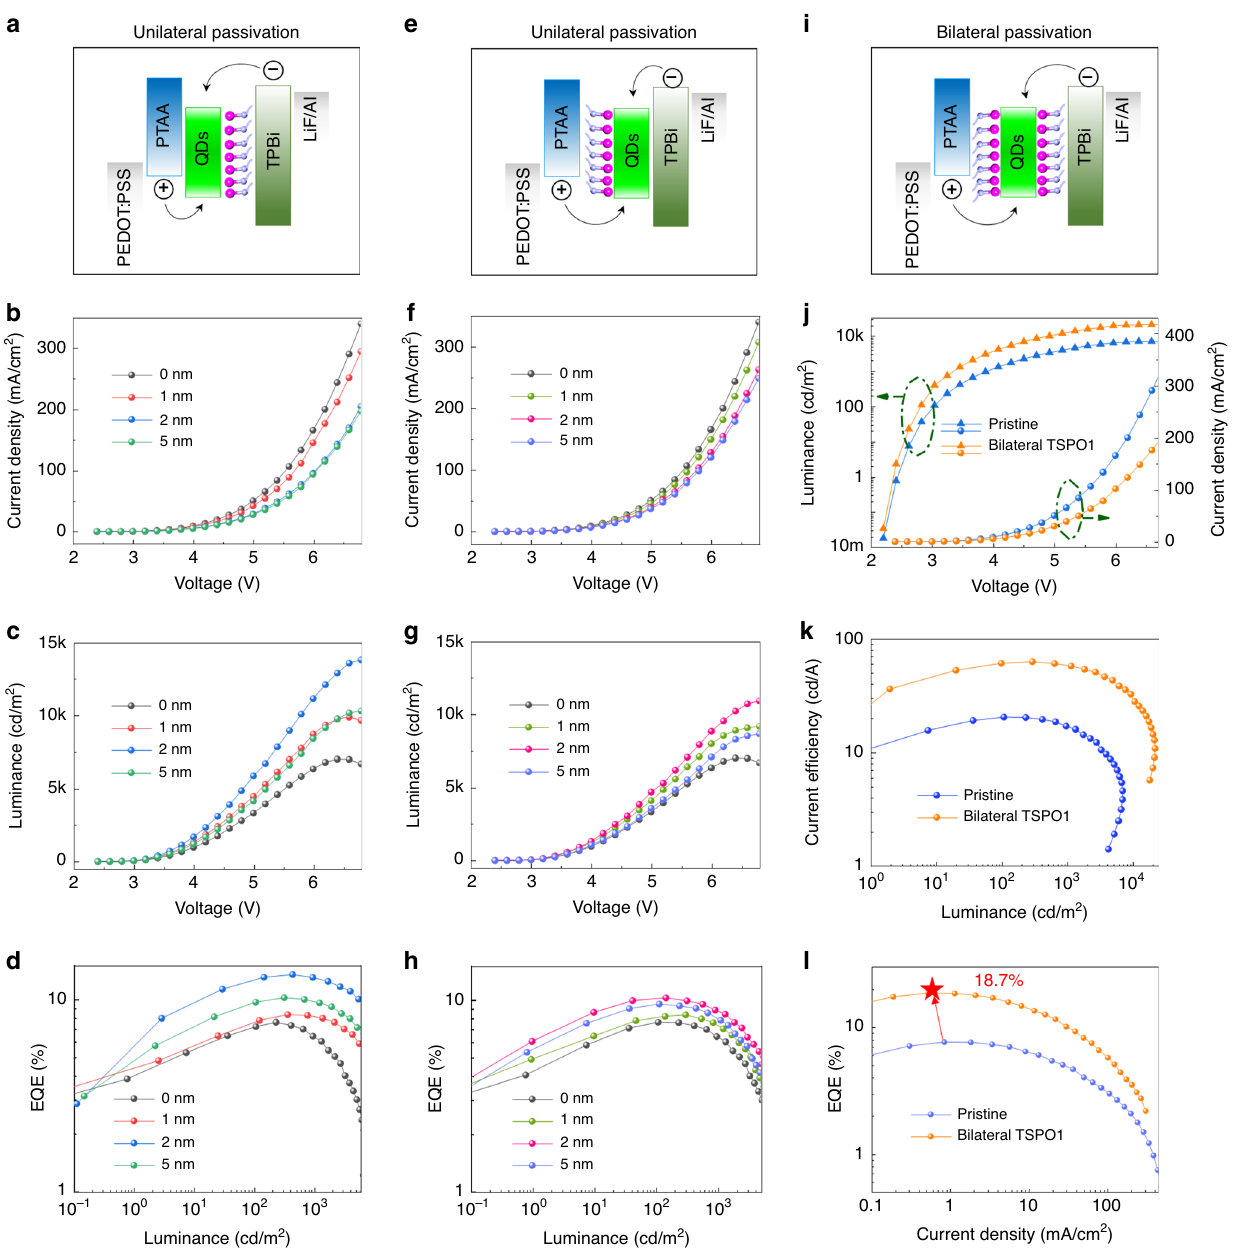
Fig. 4 EL performance comparison of QLED with different passivation states. a Energy level diagram, ( b ) current density vs. driving voltage, ( c ) luminance vs. driving voltage, and ( d ) EQE vs. luminance of device with different thickness of TSPO1 on the top side of QD layer. e Energy level diagram, ( f ) current density vs. driving voltage, ( g ) luminance vs. driving voltage, and ( h ) EQE vs. luminance of device with different thickness of TSPO1 on the bottom side of QD layer. i Energy band diagram of the bilateral-passivated device. The comparison of ( j ) current density and luminance, ( k ) current ef fi ciency, and ( l ) EQE of original device and bilateral-passivated device. Source data are provided as a Source Data fi